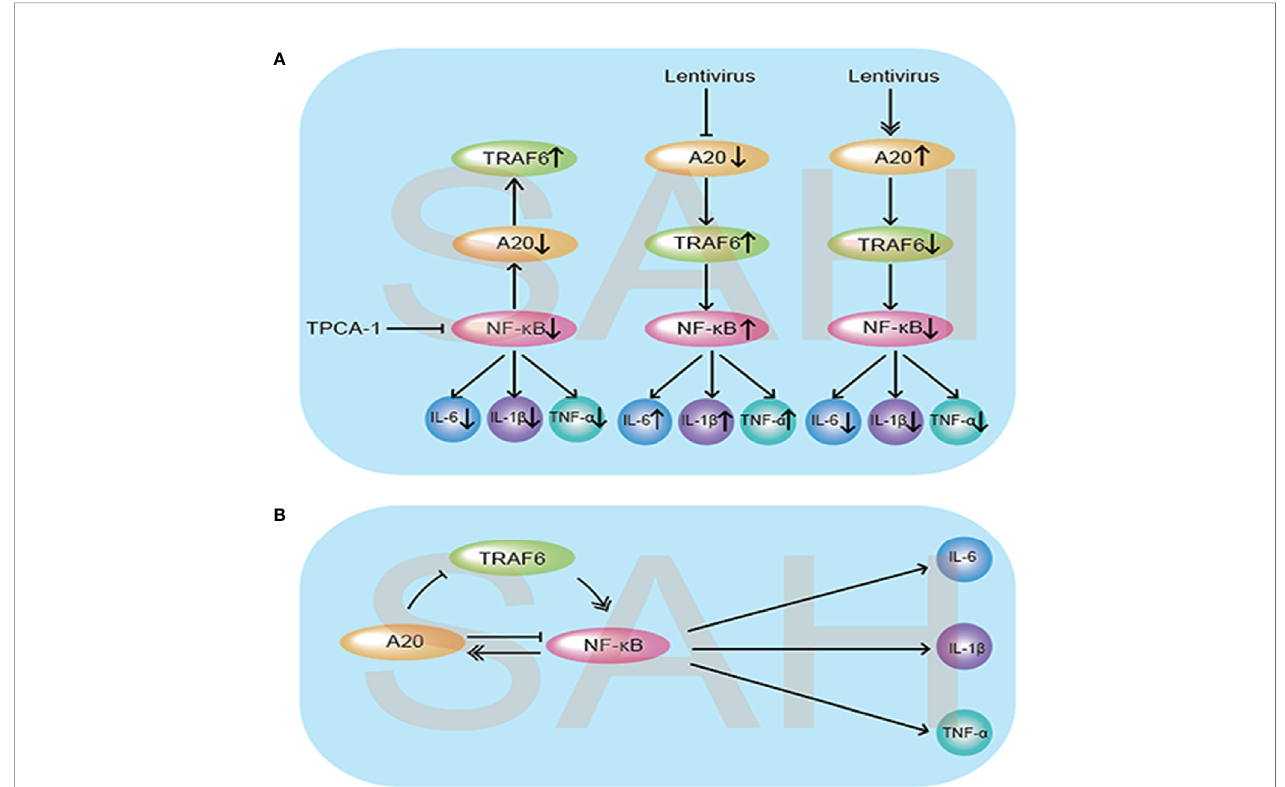
FIGURE 9 | Schematic diagram illustrating the possible negative feedback loop mechanism between A20/TRAF6/NF- k B signaling after SAH. (A) Under the SAH conditions, inhibition of NF- k B by injection of TPCA-1 caused a reduction in in fl ammatory cytokine IL-6, IL-1 b , and TNF- a release, and A20 expression was suppressed, which increased the expression of TRAF6. When A20 was inhibited by lentivirus, the expression levels of TRAF6 and NF- k B both increased, causing aggravation of the in fl ammatory response. Meanwhile, lentivirus-mediated overexpression of A20 decreased the release of in fl ammatory cytokines by suppressing TRAF6 and NF- k B. (B) As illustrated, the expression of A20 was regulated by NF- k B. In turn, the increased expression of A20 inhibited TRAF6 and NF- k B expression to reduce the subsequent in fl ammatory response and exert neuroprotective